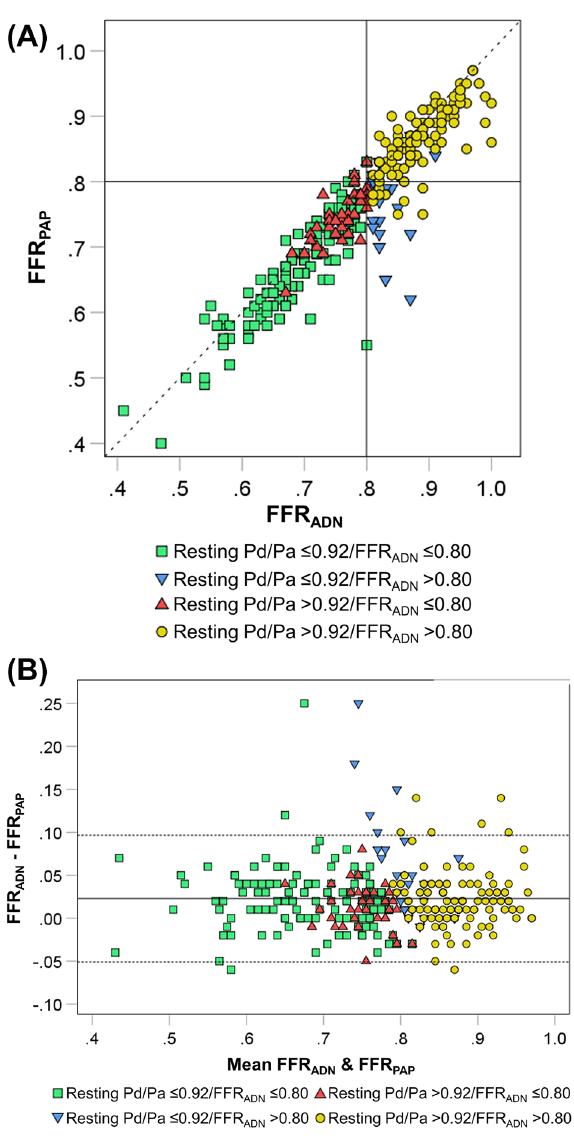
Figure 2. Comparison of FFR ADN and FFR PAP . ( A ) Scatter plot. FFR ADN and FFR PAP were highly correlated (ρ = 0.926, p < 0.001). FFR ADN fractional flow reserve value associated with adenosine, FFR PAP fractional flow reserve value associated with papaverine. ( B ) Bland–Altman plot. There was a positive bias towards the overestimation of FFR by adenosine (p < 0.001), with the mean difference of 0.02 and the 95% limits of agreements of − 0.05 and